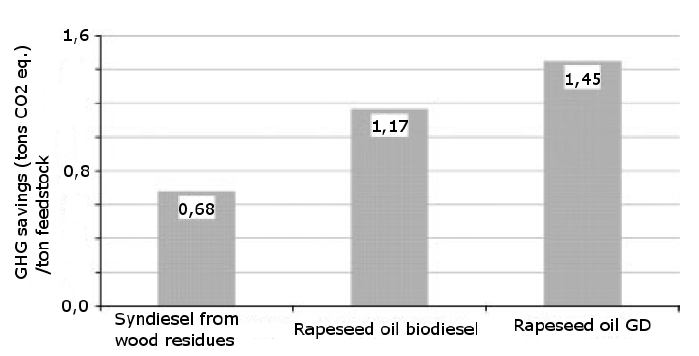
GHG savings per ton of feedstock when comparing the three technologies involved [18]. GD = HVO; Biodiesel = Transesterified